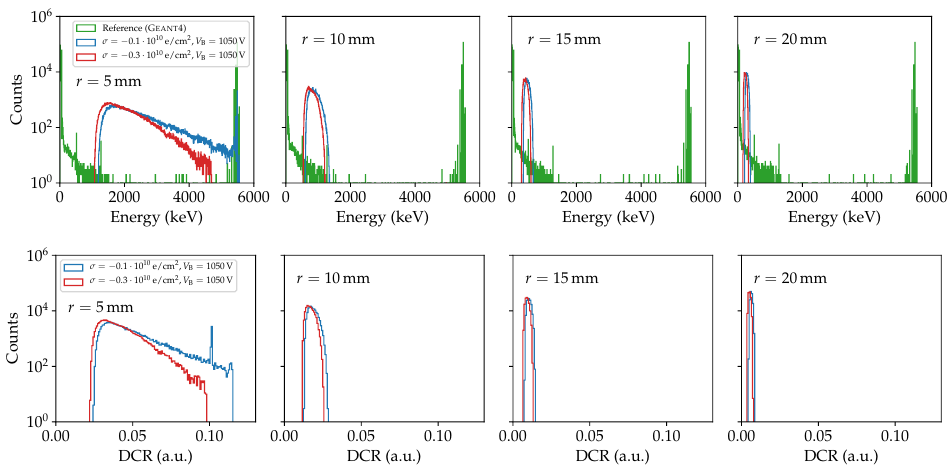
Figure 18. Simulated energy spectra E true α (G EANT 4 reference, green curve), E obs α (blue and red curves) ( upper row ), and DCR distributions ( lower row ) of the 241 Am events at selected r . The simulated E obs α distributions are shown for negative surface charges σ =